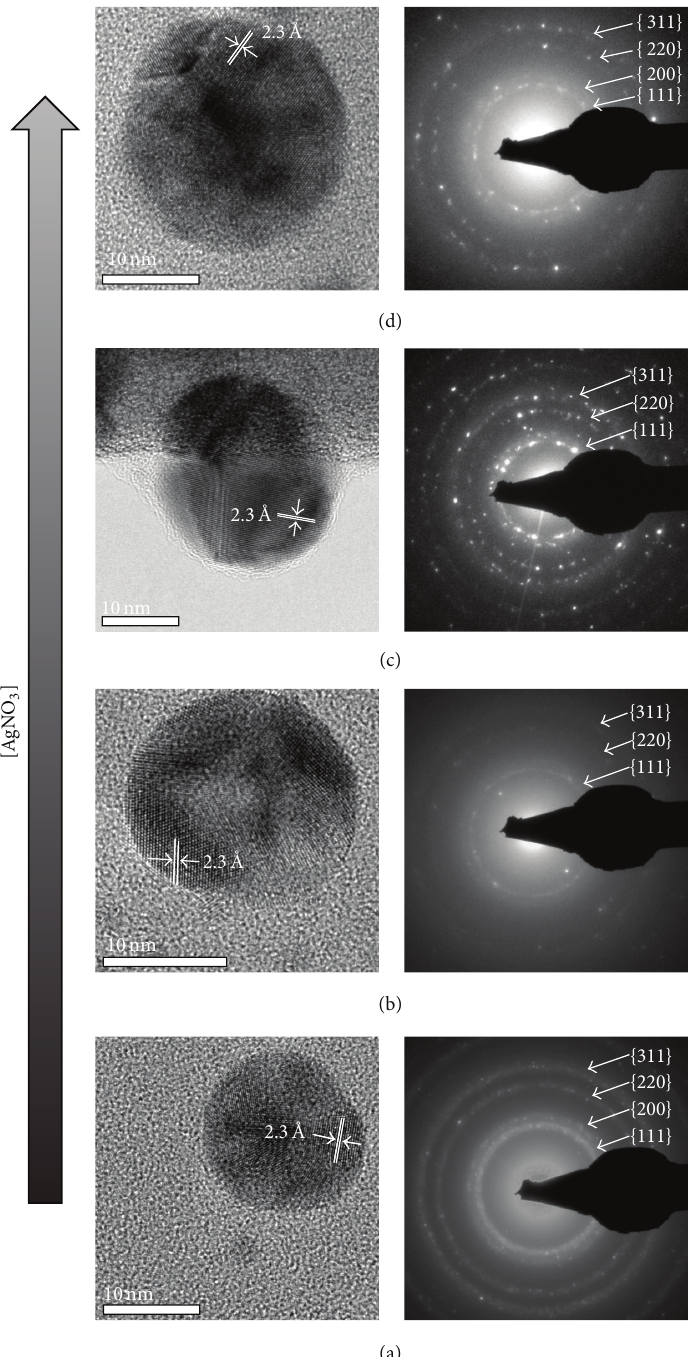
Figure 2: High magnification BF images that show nanoparticles of the samples: (a) AgCMC1, (b) AgCMC2, (c) AgCMC3, and (d) AgCMC4, along with their correspondent SAED pattern. The SAED pattern of each sample is located on the right hand of its correspondent BF